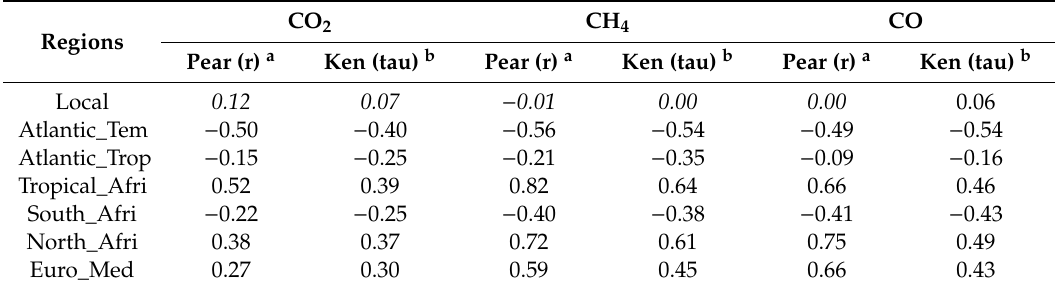
Table 1. Correlations between the respective potential emission sensitivity (PES) values for each region and CO 2 , CH 4 , and